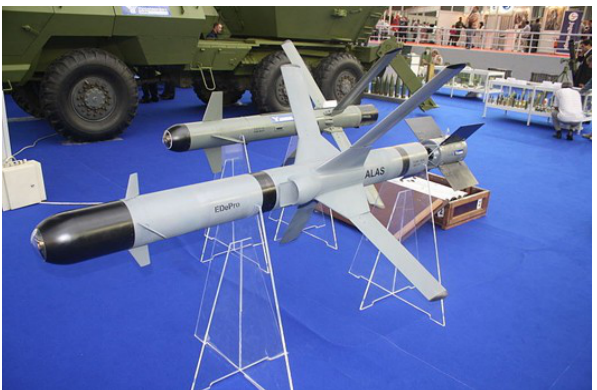
Figure 5 – ALAS rocket system (Radio Television of Serbia, 2013) Рис . 5 – Ракетная система „ АЛАС “ (Radio Television of Serbia, 2013) Слика 5 – Ракетни систем „ АЛАС ” (Radio Television of Serbia,